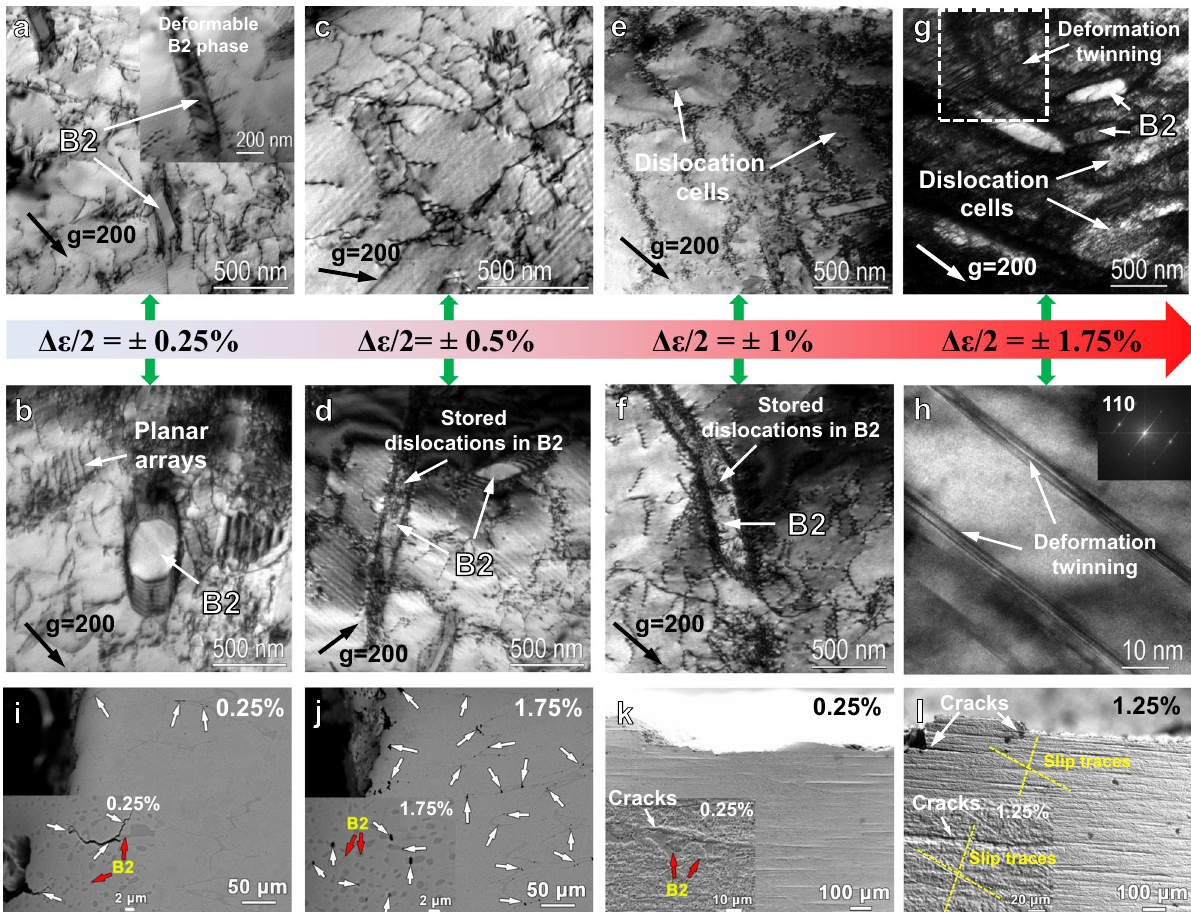
Fig. 4 TEM and SEM characterized structural evolutions at different strain amplitudes. a , b ; c , d ; e , f ; and g , h are the TEM bright- fi eld (BF) images at the strain amplitudes of ±0.25%, ±0.5%, ±1%, and ±1.75%, respectively, showing the structural evolution of the cyclic response of deformation features (the inset fi gure in Fig. 5a) is the dark- fi eld (DF) image, presenting the plastically-deformable B2 phase). i – l are the SEM images of the fractured samples at the strain amplitudes of ±0.25%, ±1.25%, and ±1.75%, exhibiting the crack-formation features at low and high strain